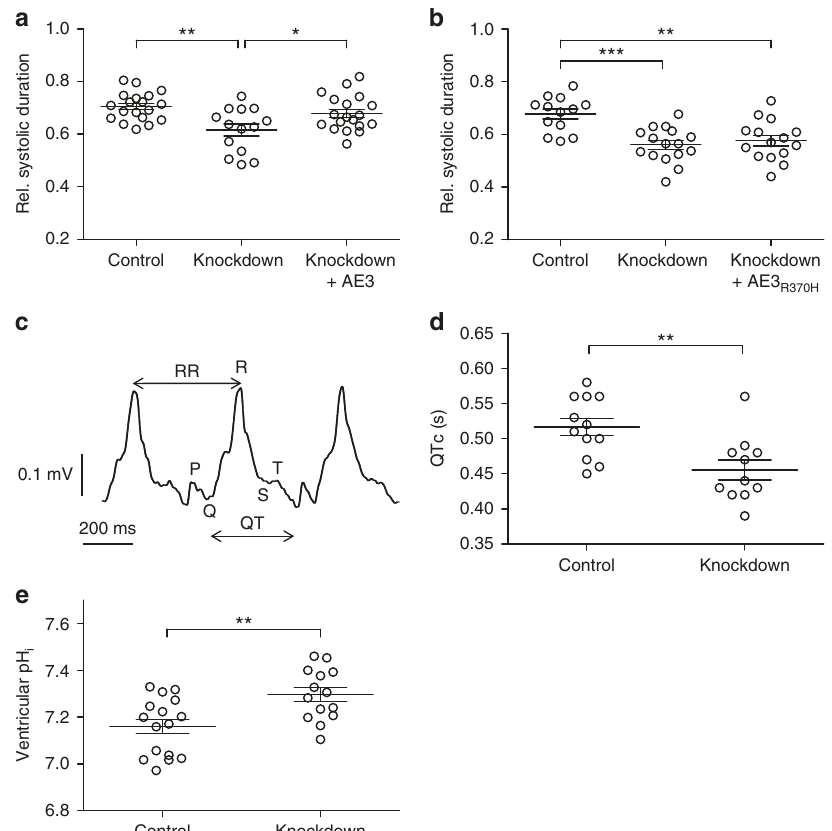
Fig. 3 Loss of slc4a3 in zebra fi sh embryos replicates the QTc shortening observed in patients. a Systolic interval divided by heart cycle duration is signi fi cantly reduced in slc4a3 knockdown embryos 2 days post fertilization (dpf). This phenotype is rescued by overexpression of AE3 in knockdown embryos. n = 19 (Control), n = 14 (Knockdown), and n = 19 (Knockdown + AE3) compiled from three independent experiments, each including all three experimental groups. b Reduced systolic interval in slc4a3 knockdown embryos is not rescued by overexpression of R370H-mutated AE3 in knockdown embryos. n = 13 (Control), n = 16 (Knockdown), and n = 15 (Knockdown + AE3 R370H ) compiled from three independent experiments, each including all three experimental groups. c A raw ECG recording of a 2 dpf zebra fi sh embryo; P,Q,R,S,T waves, and RR and QT intervals indicated. d Corrected QT intervals (QTc) for control and slc4a3 knockdown embryos were calculated with Bazett ’ s formula. n = 12 (Control) and n = 11 (Knockdown) compiled from three independent experiments, each including both experimental groups. e pH i is signi fi cantly increased in hearts from slc4a3 knockdown embryos 2 days post fertilization (dpf). n = 16 (Control), n = 14 (Knockdown). * p < 0.05, ** p < 0.01, *** p < 0.001 as determined by one way ANOVA with Tukey ’ s post-test ( a , b ) or unpaired student t-test ( d , e ). Error bars throughout represent the